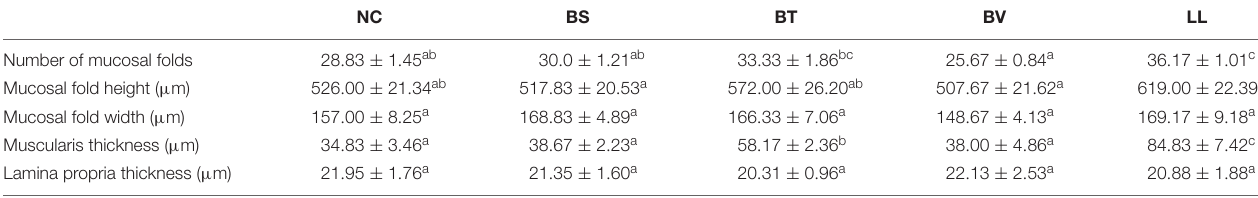
TABLE 5 | Jejunum morphological indices of bullfrog.